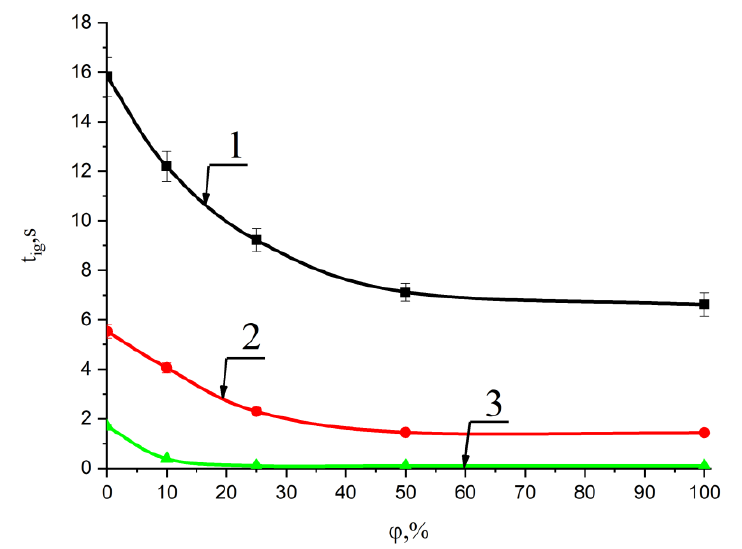
Figure 4. Change in the ignition delay time of mixed fuel pellets based on T grade coal with an increase in the concentration of cedar husks at ambient temperatures: 1—600 ◦ C; 2—700 ◦ C; and 3—800 ◦ C. The ϕ coefficient shows the concentration of the cedar husk component in a mixture with coal.